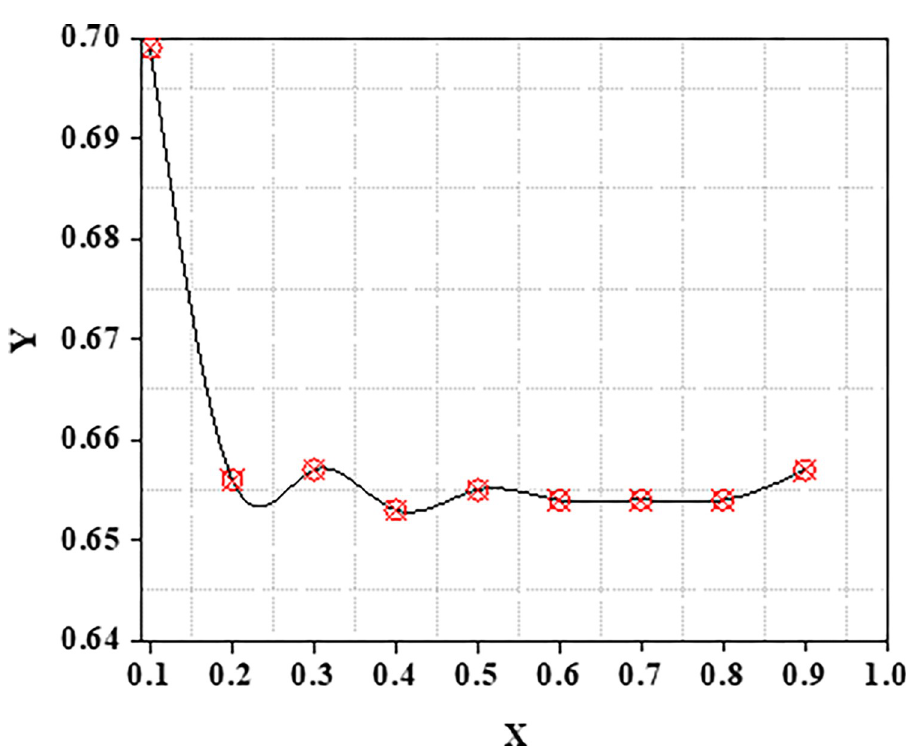
Fig 10. Y: Average MAE with various X: μ